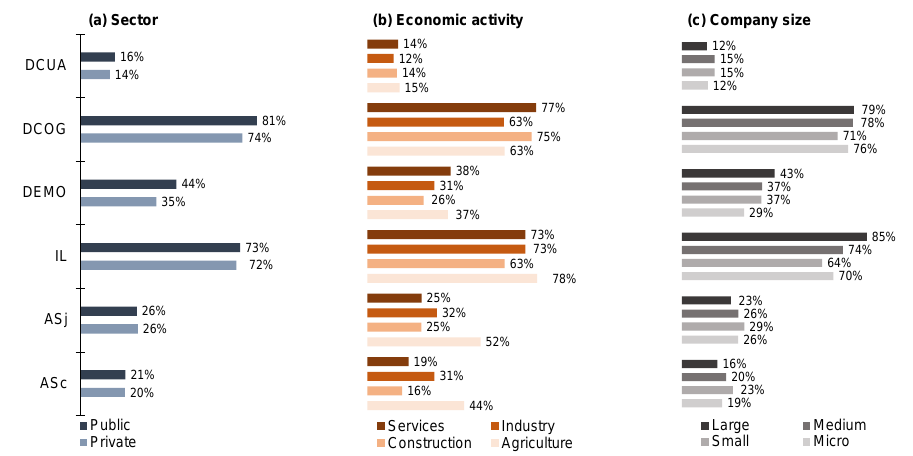
Figure 2. Psychosocial risk factors by job characteristics ( n = 1049). ASc = social support from colleagues (% answered No), ASj = social support from bosses (% answered No), IL = job insecurity (% answered Yes), DEMO = emotional demand (% answered Yes/Partly), DCOG = cognitive demand (% answered Yes/Partly), DCUA = quantitative demand (% answered No/Partly).